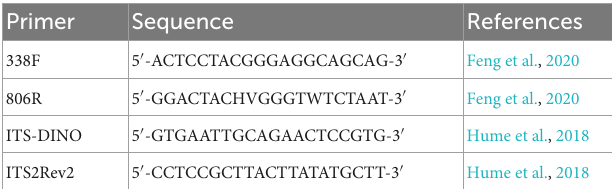
TABLE 1 Primer pairs tested.